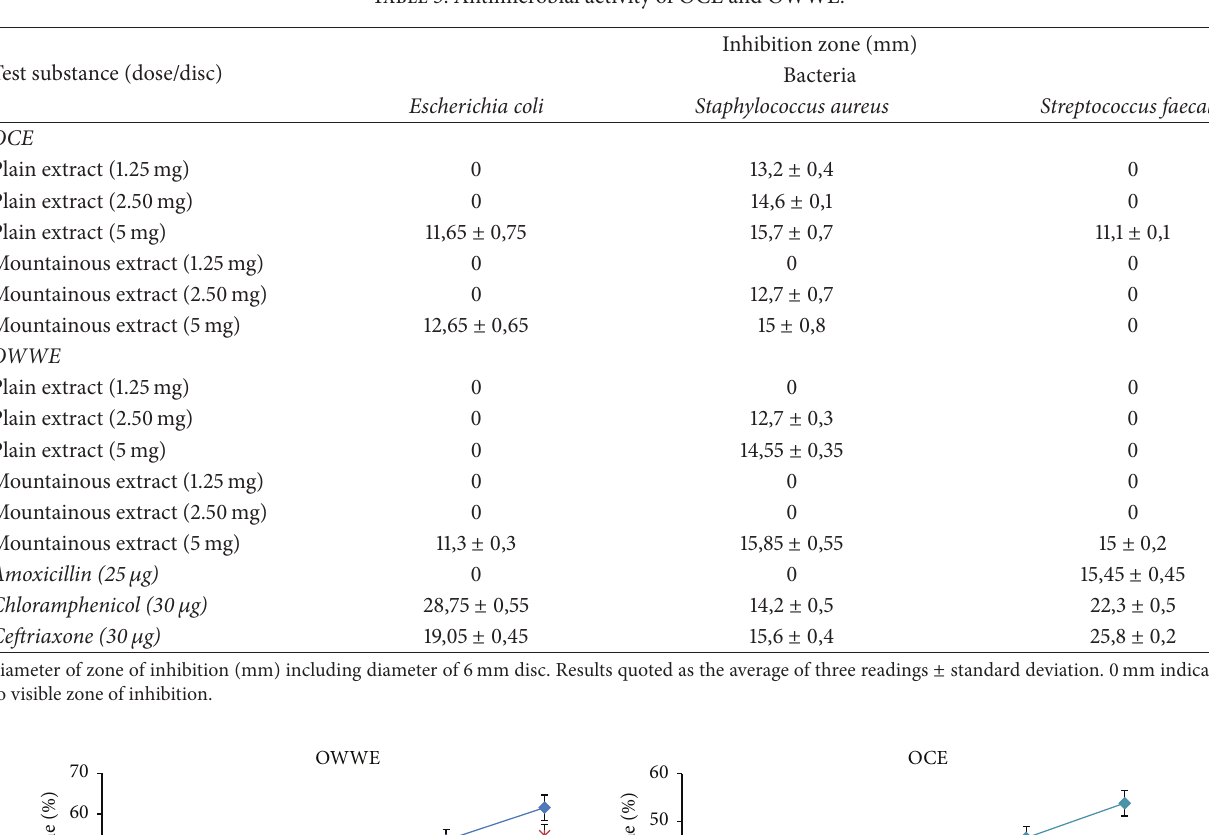
Table 5: Antimicrobial activity of OCE and OWWE.